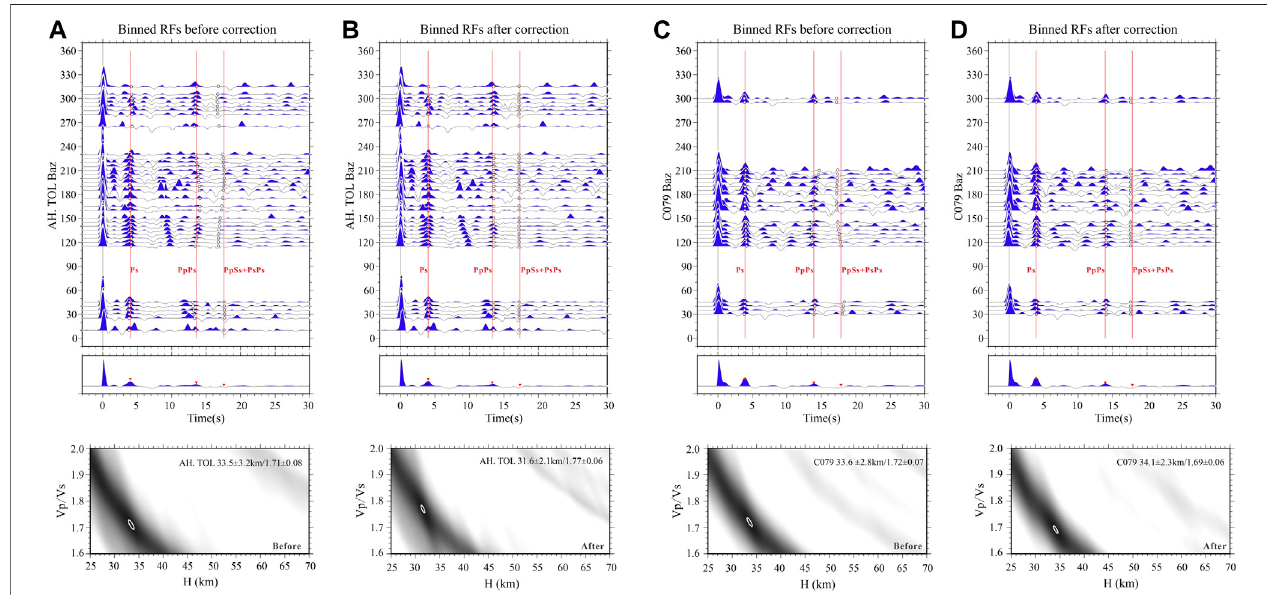
FIGURE 3 | Arrival time and waveform fi tting of the Pms and multiples before (A,C) and after (B,D) harmonic corrections. The white circles represent the peak amplitude of the Pms and multiples. The dynamic correction stacking is shown below (ray parameter is 0.06 s/km), where the red lines and inverted triangles represent the arrivals of the Pms and multiple phases, respectively. H- κ energy maps are indicated at the bottom of the fi gures; the obtained H and Vp/Vs ( κ ), as well as corresponding errors and error ellipses, are shown.